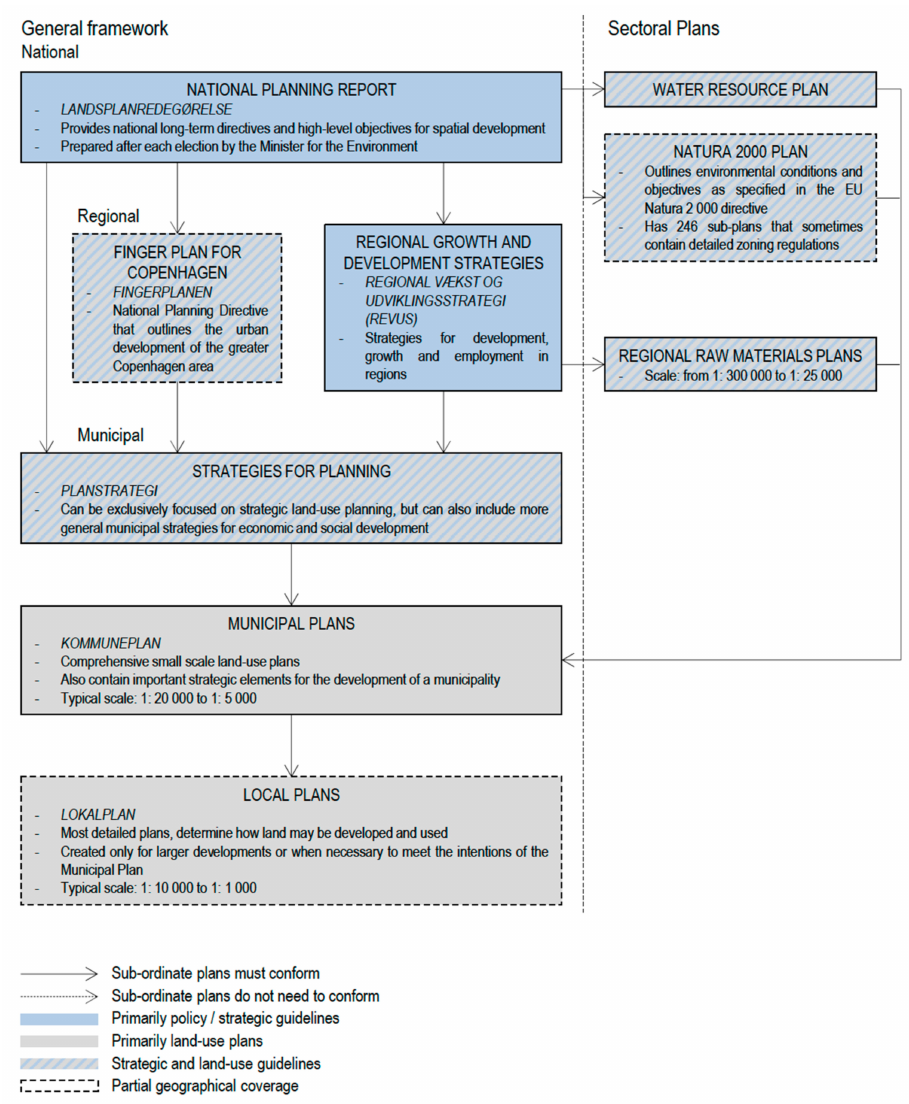
Figure 14. Organisation of spatial and land-use planning in Denmark